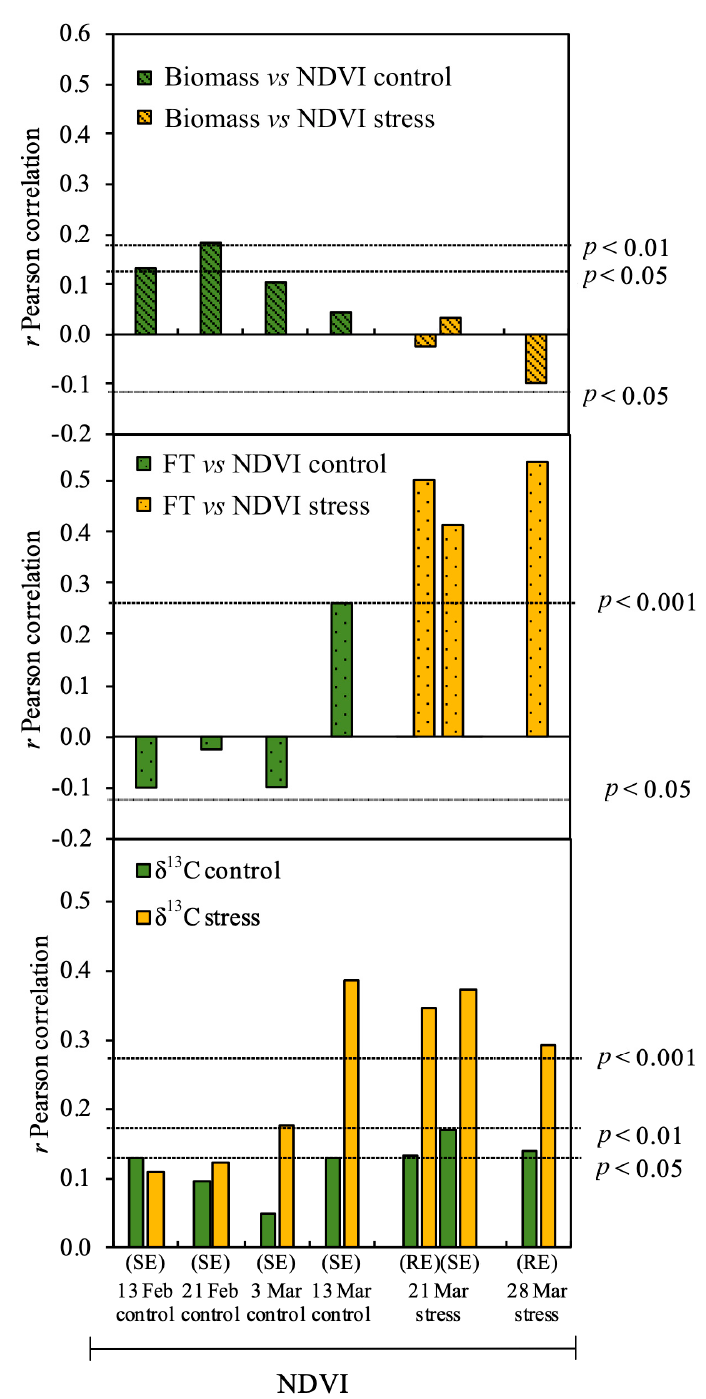
Figure 3. Pearson correlation coefficients of the relationship between the Normalized Difference Vegetation Index (NDVI) measured on different days using Sequoia (SE) and RedEdge (RE) sensors versus the biomass (upper panel), flowering time (FT) (middle panel), and stable carbon isotope compositions ( δ 13 C) of the flag leaf dry matter before stress conditions were imposed in the field ( δ 13 C control) and about two weeks after the last irrigation ( δ 13 C stress) (lower panel) in a panel of 248 durum wheat elite advanced lines and cultivars from around the world. Level of significance p < 0.05; p < 0.01; p < 0.001.